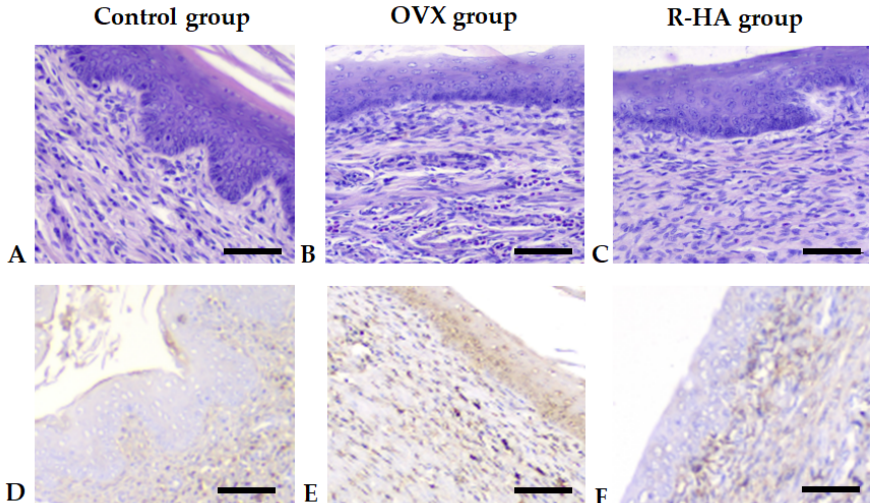
Figure 3. Impact of ovariectomy and R-HA treatment on vaginal mucosa. ( A – C )—H&E staining. Scale bars 50 µm. ( D – F )—Immunohistochemistry demonstrating COX-2 expression. Scale bars